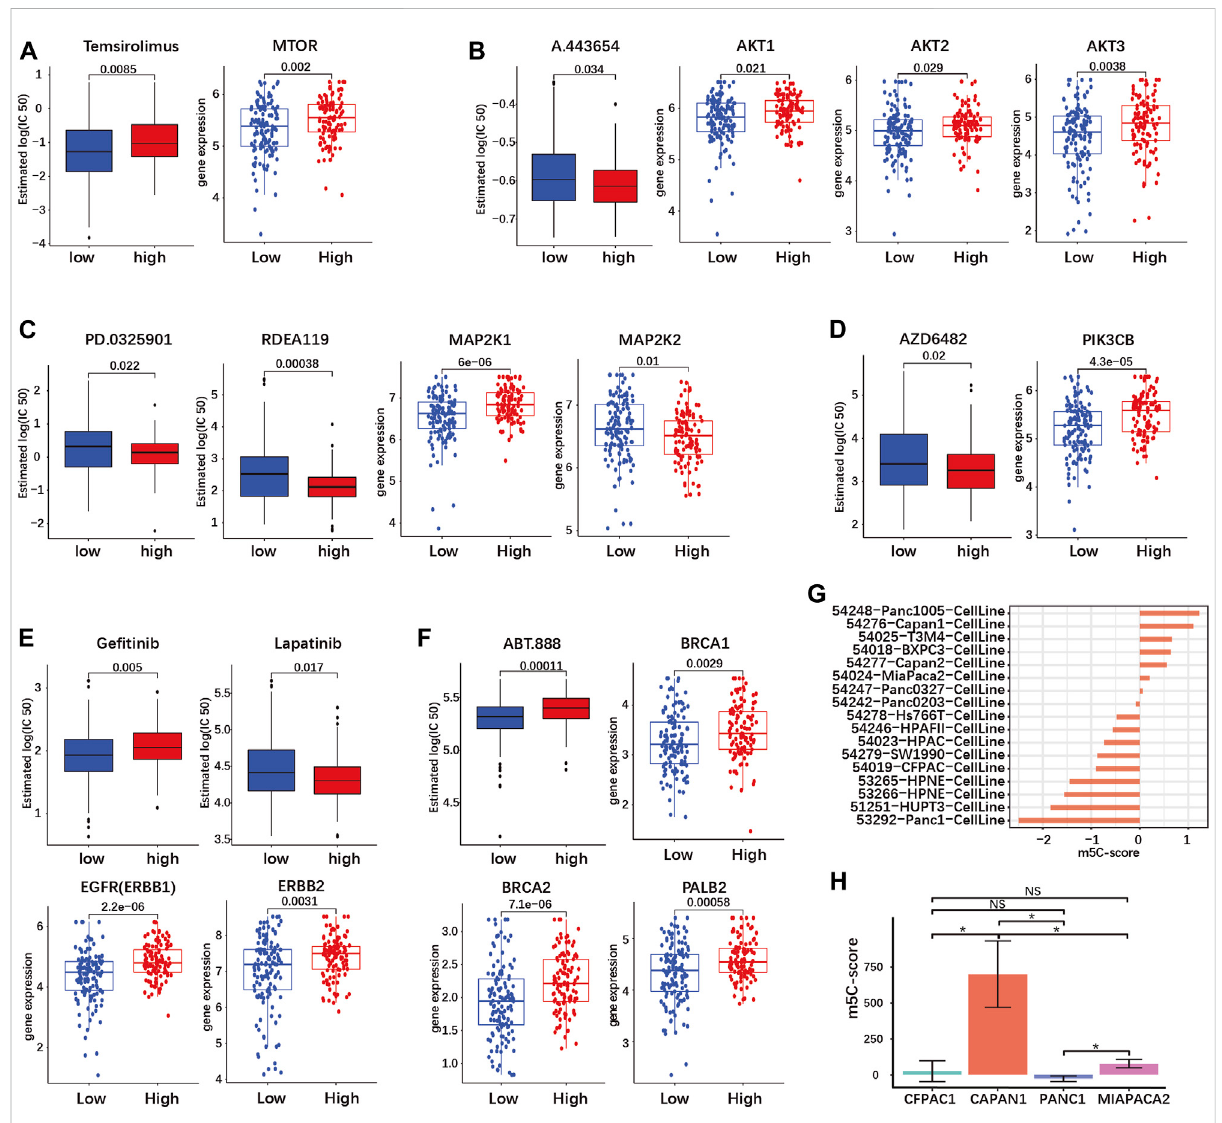
FIGURE 7 The m5C-score can predict target drug response in PDAC. Target drug IC50 prediction and differential expression analyses of target genes between high- and low-m5C-score groups in the TCGA-PAAD and GSE57495 cohorts are given for (A) mTOR inhibitor (MTOR gene); (B) AKT inhibitor (AKT 1/2/3 genes); (C) MEK1 and 2 inhibitors (MEK1 and MEK2 genes - MAP2K1/2); (D) PI3K inhibitor (PIK3CB gene); (E) EGFR and HER2 inhibitors (EGFR — ERBB1 — and HER2 — ERBB2 — genes; (F) PARP inhibitor (BRC1/2 and PALB2 genes). (G) The m5C-score comparison of different PDAC cell line type from GSE165949. (H) The m5C-score comparison of different PDAC cell lines from the Mof fi tt ’ s